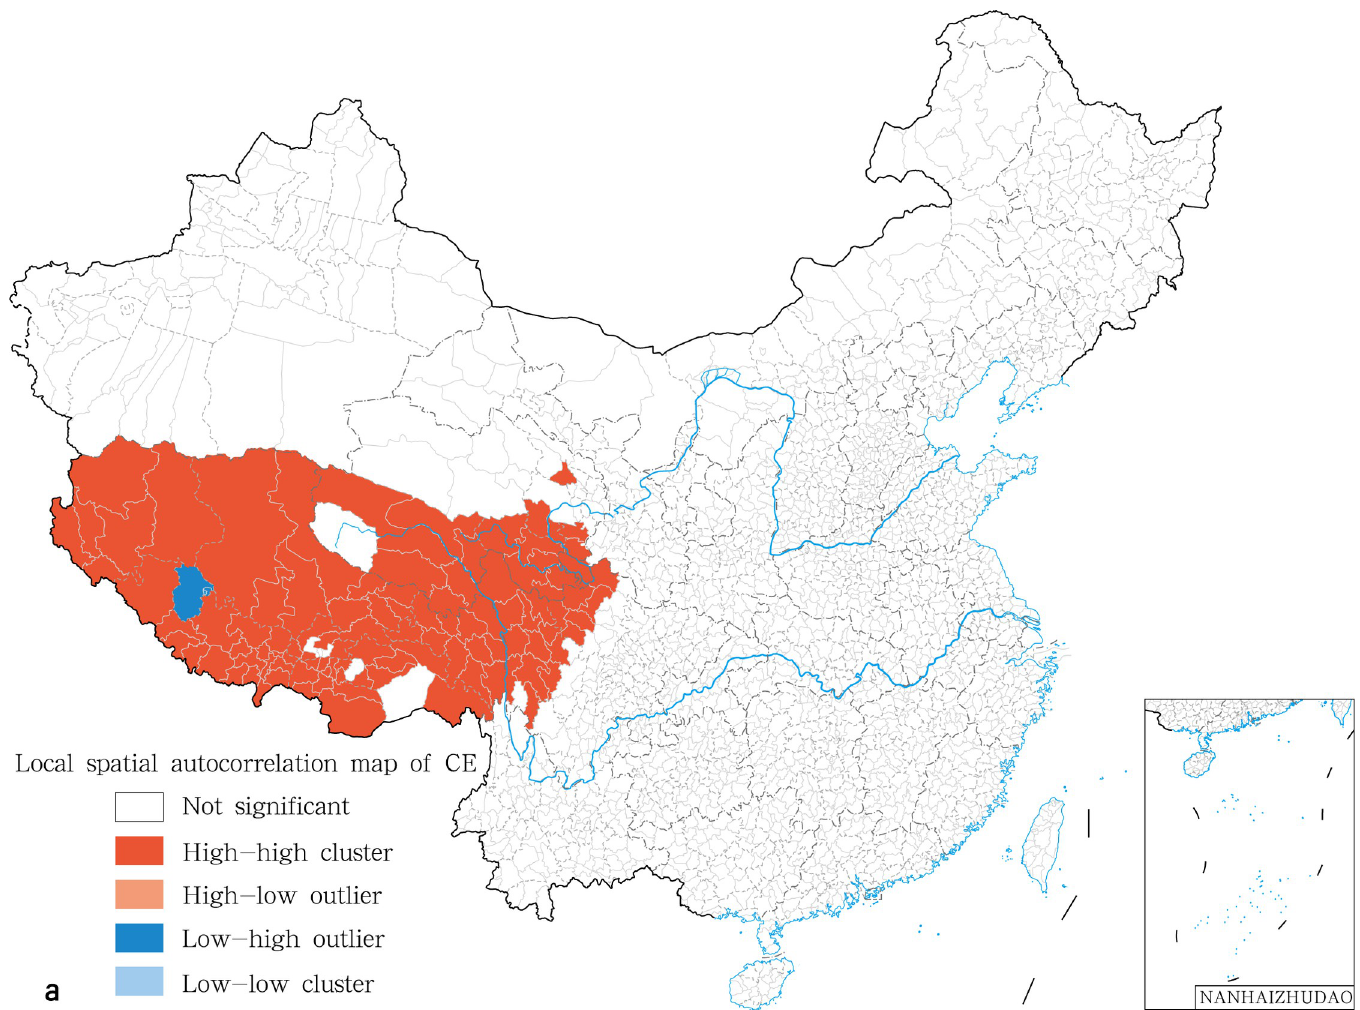
Fig 4. Local spatial autocorrelation map of human CE in China in 2018. The base layer is from https://www.webmap.cn/mapDataAction.do?method=forw&resType=